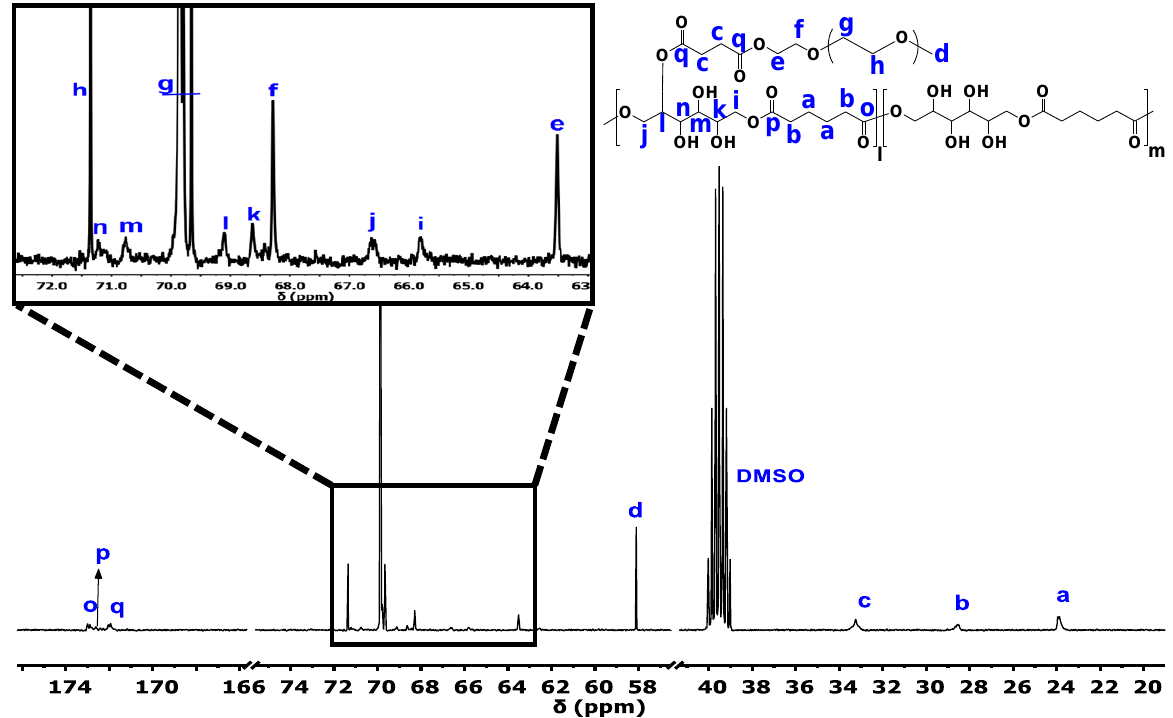
Figure 2. 13 C NMR spectrum of PSA- g -mPEG 12 measured at 27 °C using DMSO-d 6 as solvent.